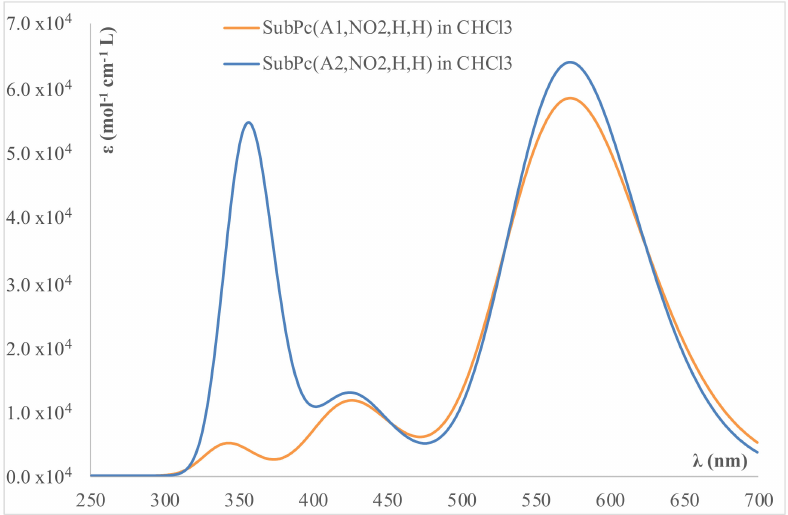
Figure 4. Comparison between the calculated UV-visible spectra of SubPc(A1,NO 2 ,H,H) and SubPc(A1,NO 2